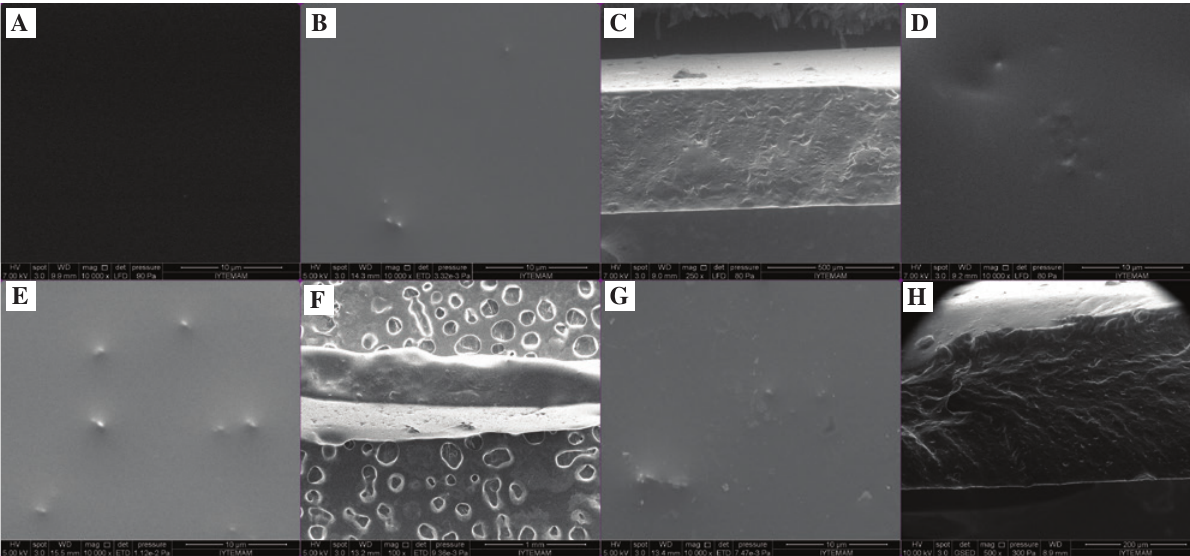
, (B) Cel-PO -Gr 0.2, (C) Cel-PO 4 4 -0.6Gr, (H) Cel-PO 4